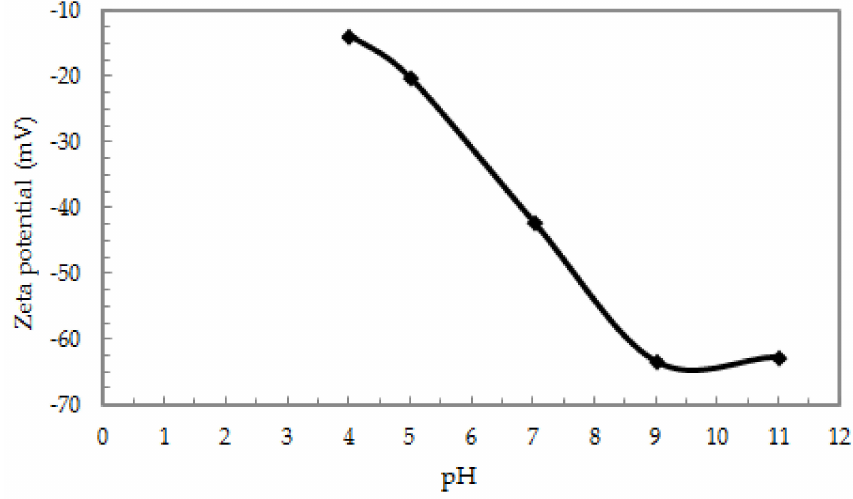
Figure 6. Zeta potential curve of ox-xGnP suspension versus solution